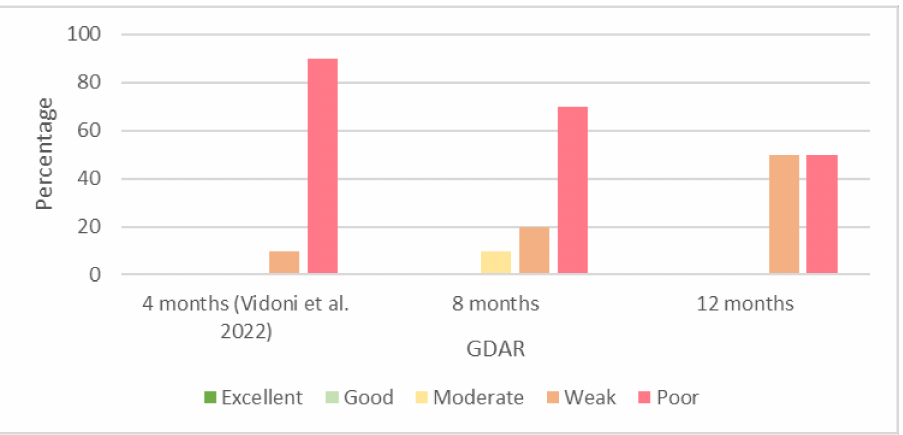
Figure 5. Percentages of results of interobserver agreements (Cohen’s kappa coefficient) for grading of dorsal acetabular rim (GDAR) at 4 [29], 8, and 12 months of